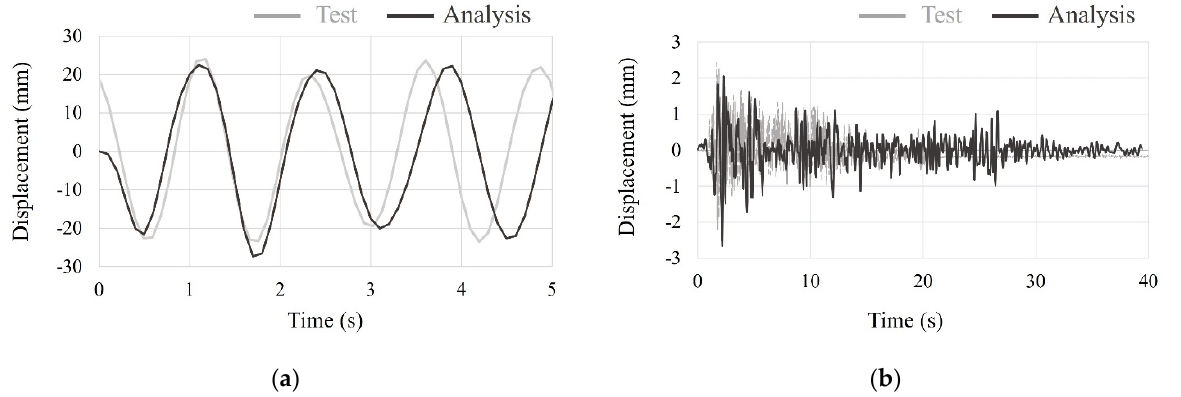
Figure 16. Analysis and test results of the small-scale model by: ( a ) sinusoidal forced vibration; ( b ) scaled El Centro earthquake vibration.